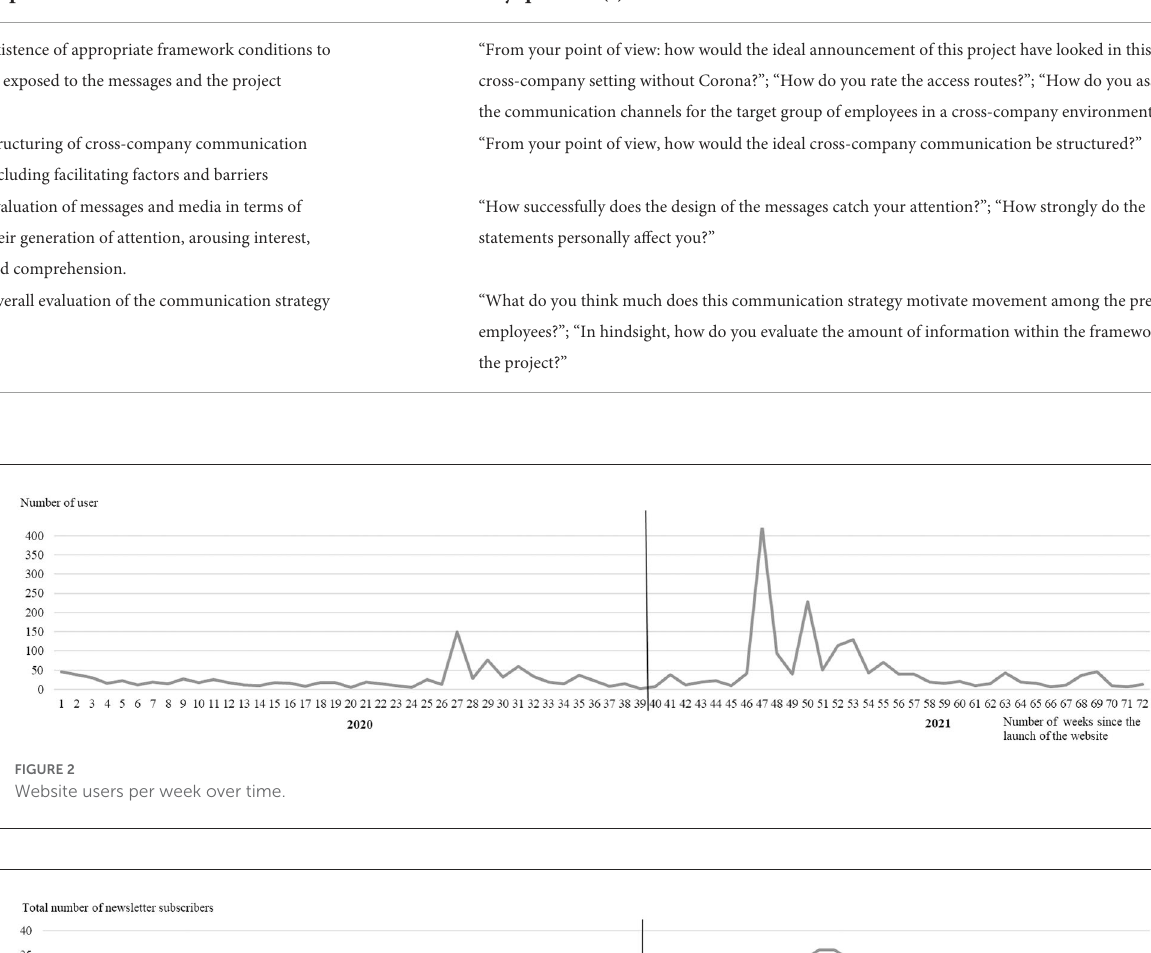
TABLE 2 Topics and key questions of the interview guide (translated from German). Topic